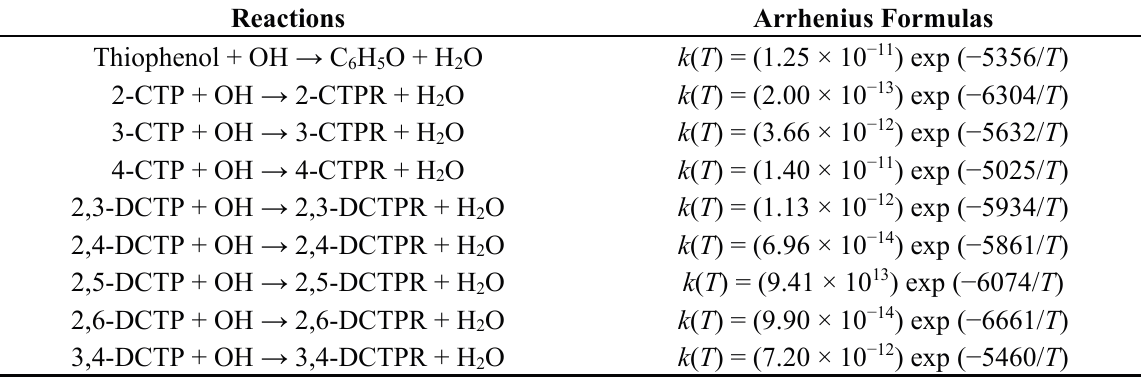
Table 4. Arrhenius formulas (in cm 3 ·molecule − 1 ·s − 1 ) for the triophenoxyl-hydrogen abstraction from chlorothiophenols and thiophenol by OH over the temperature range of 600–1200 K.